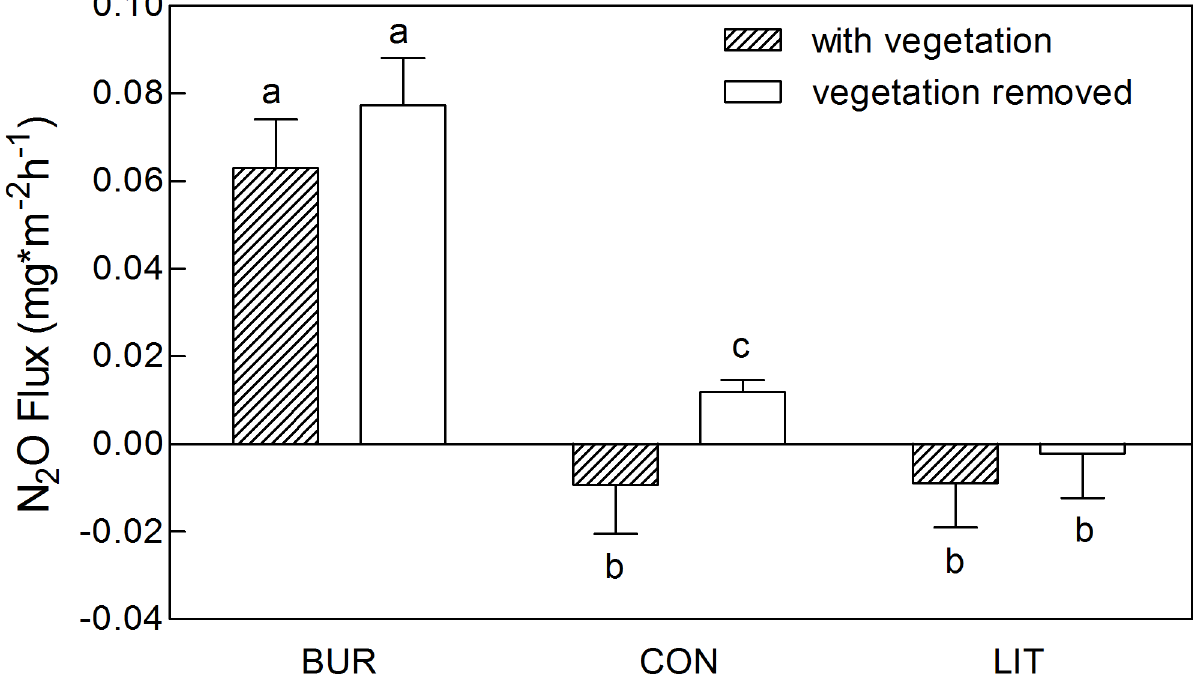
Fig 2. N 2 O fluxes from the sampling